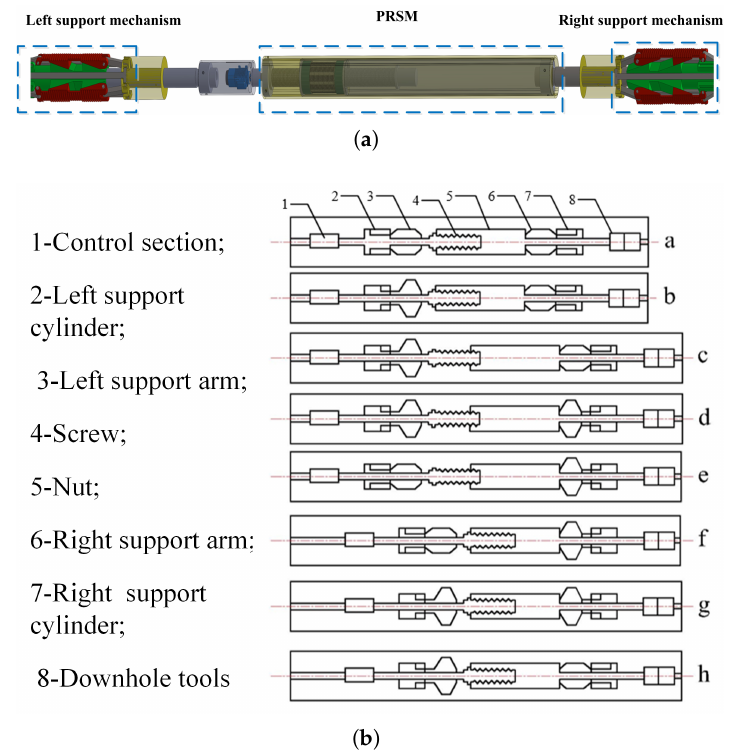
Figure 3. ( a ) The three-dimensional model of the downhole robot system; ( b ) the working mechanism of the downhole robot system.